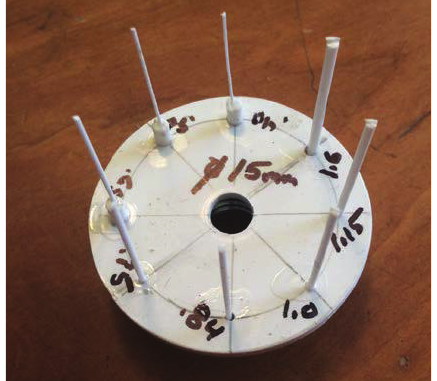
Figure 6: Contrast phantom.